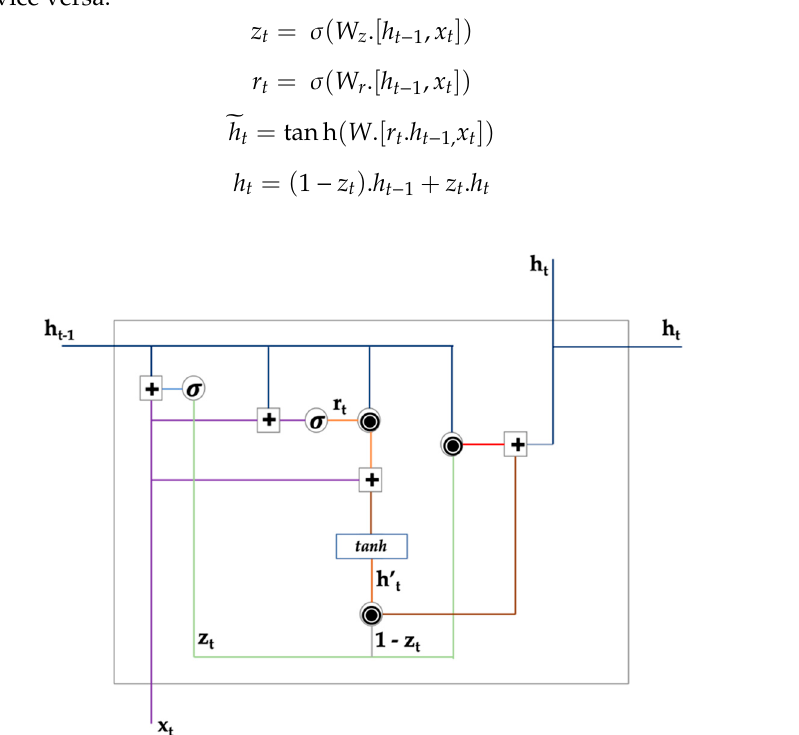
Figure 2. Architecture of a gated recurring unit (GRU) unit. + : “plus” operation; ◉ : “Hadamard product” operation; 𝜎 : “sigmoid” function; tanh : “tanh”